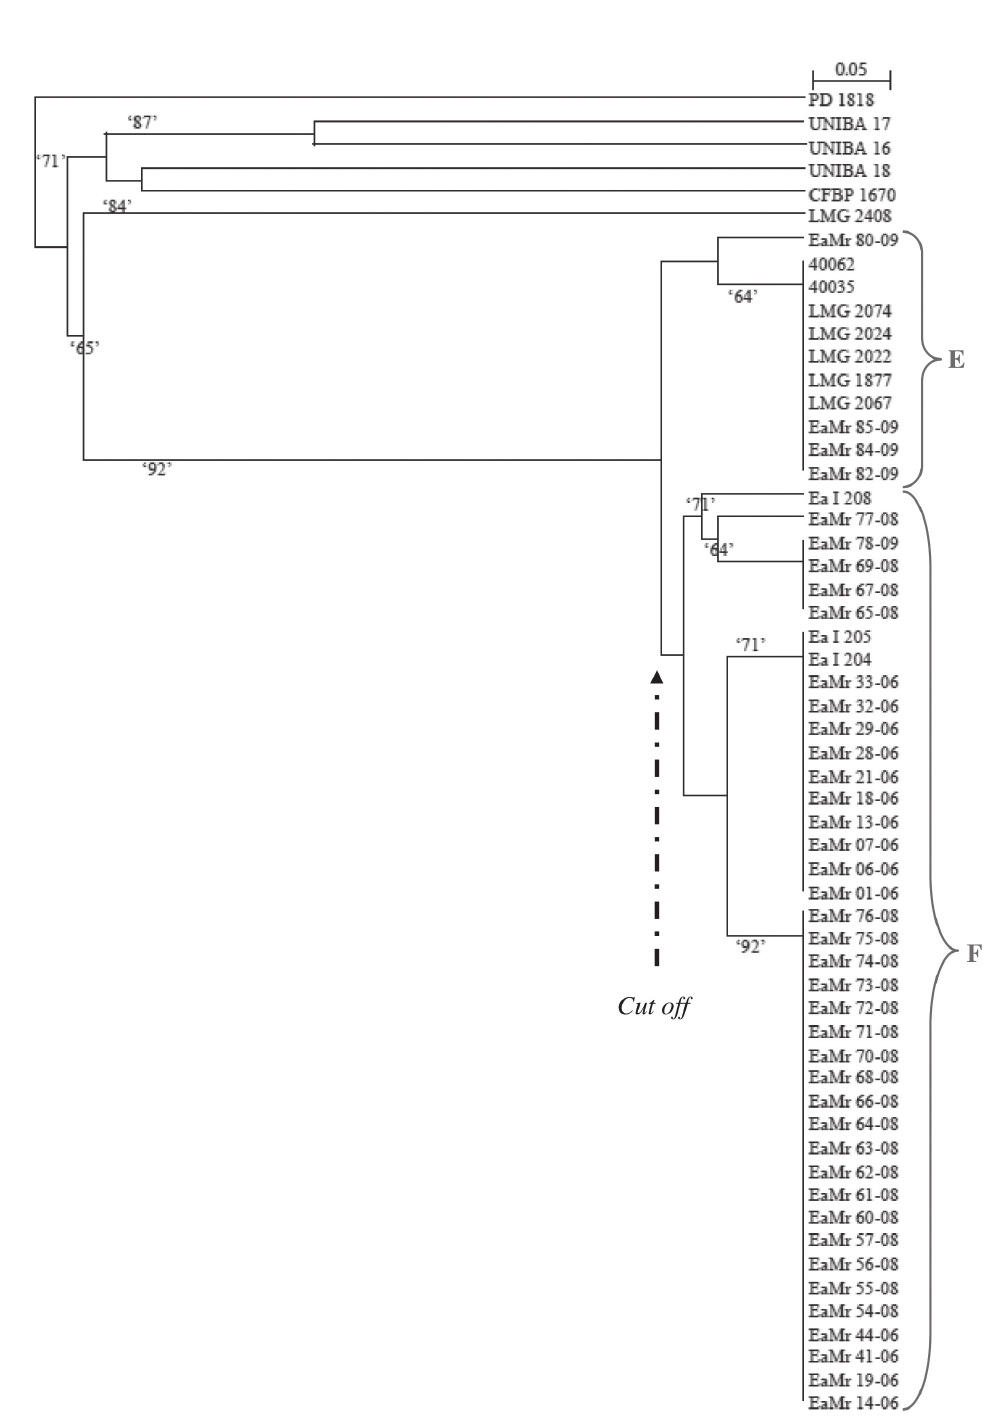
Figure 4. Dendrogram of Erwinia amylovora strains derived from rep-PCR DNA fi ngerprints generated from the ERIC primer. Dendrogram was calculated with unweighted pair-group method with average linkages (UPGMA) us- ing the Jaccard’s coef fi cient and the robustness of the tree was assessed by bootstrap